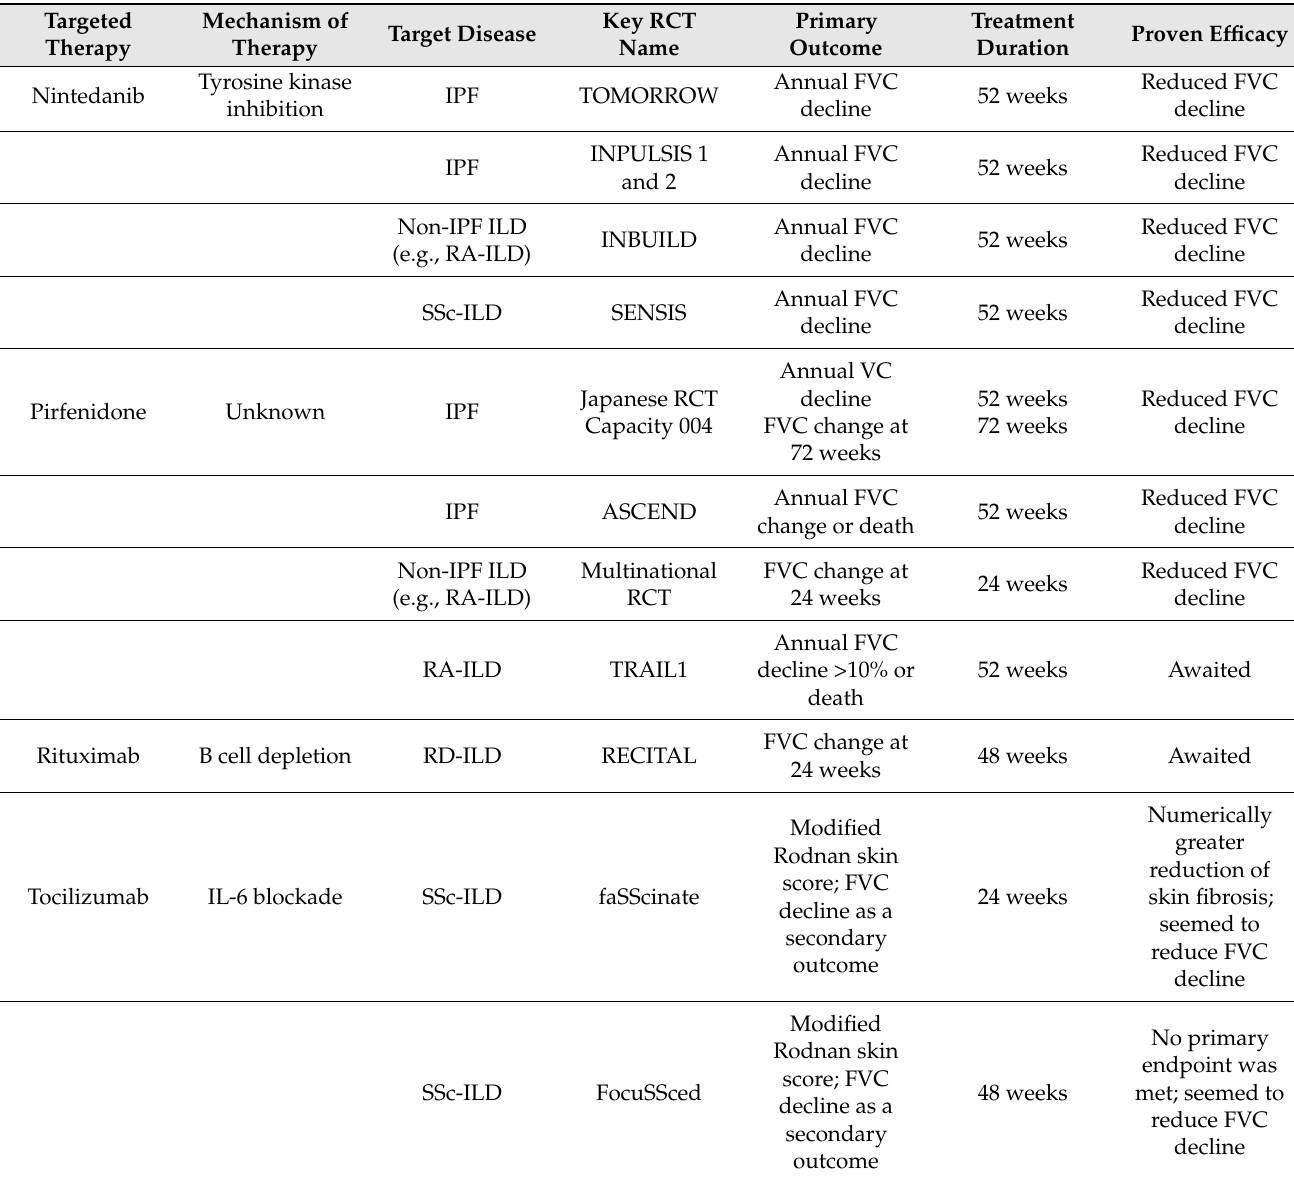
Table 1. Recent clinical trials on targeted drugs for idiopathic pulmonary fibrosis and rheumatic disease-associated interstitial lung